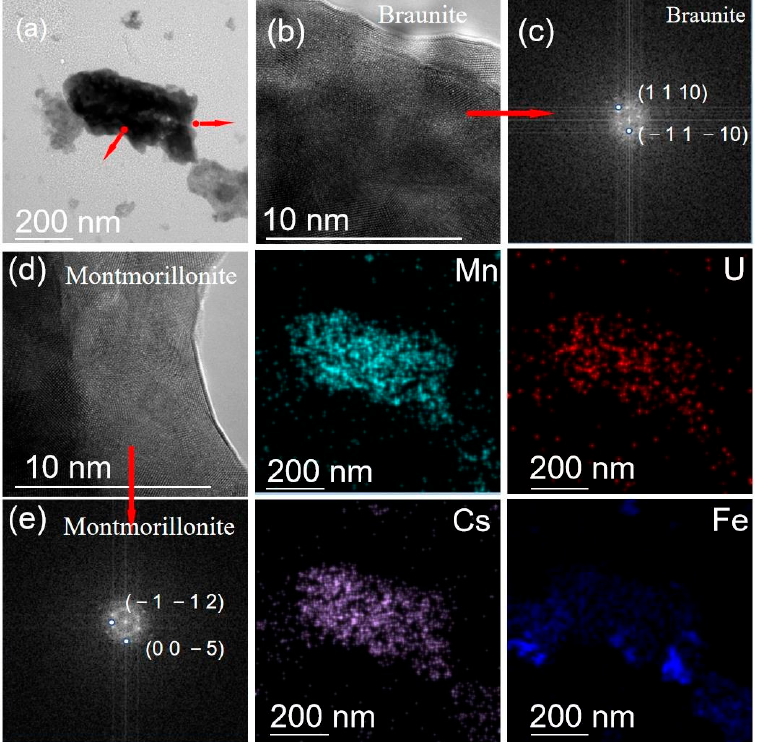
Figure 5. TEM mappings of selected S5 soil sample. ( a ) TEM image; ( b , d ) HRTEM image; ( c , e ) FFT image EM maps of particle.